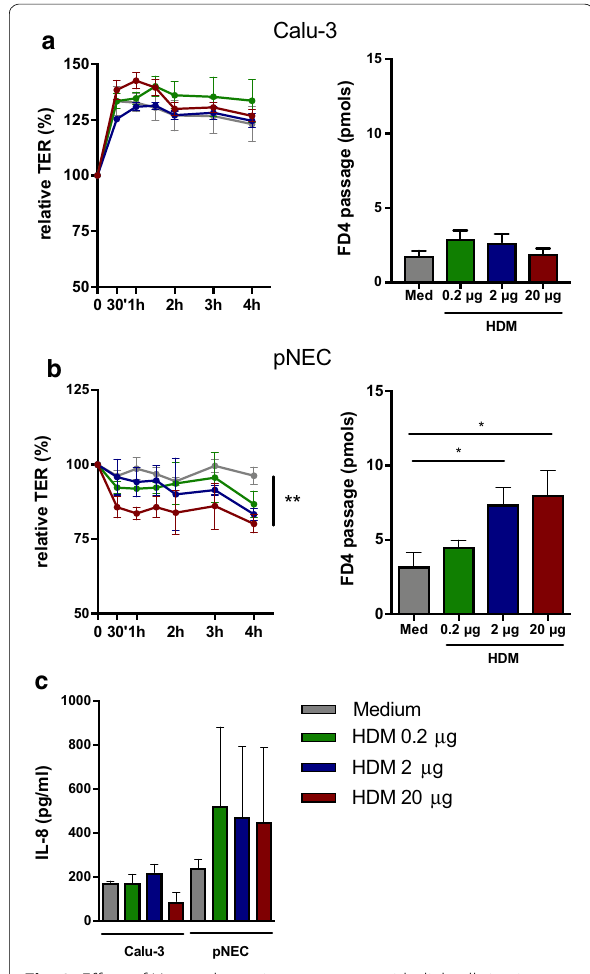
Fig. 2 Effect of House dust mite extract on epithelial cells in vitro. Primary nasal epithelial cells (n 5) and Calu-3 epithelial cells = (n 3) at air–liquid interface were stimulated for 4 h with different = concentrations of house dust mite (HDM) extract. a Evaluation of trans-epithelial electrical resistance (TER) for 4 h of Calu-3 epithelial cell cultures. FD4 permeability of Calu-3 epithelial cells at time point 4 h. b Evaluation of TER for 4 h of primary nasal epithelial cells from heathy controls. FD4 permeability of primary nasal epithelial cells at time point 4 h. c Concentration of IL-8 in the supernatant of HDM stimulated Calu-3 or primary nasal epithelial cell cultures. Data presented as mean SEM. One-way ANOVA with post hoc test. ± * p < 0.05; ** p < 0.01; *** p < 0.001; ns not